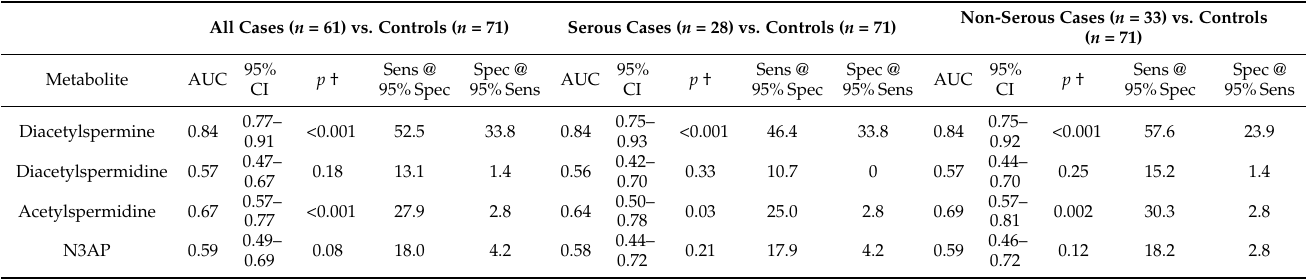
Table A7. Classification performance of plasma polyamines in distinguishing serous or non-serous cases from controls in the Validation